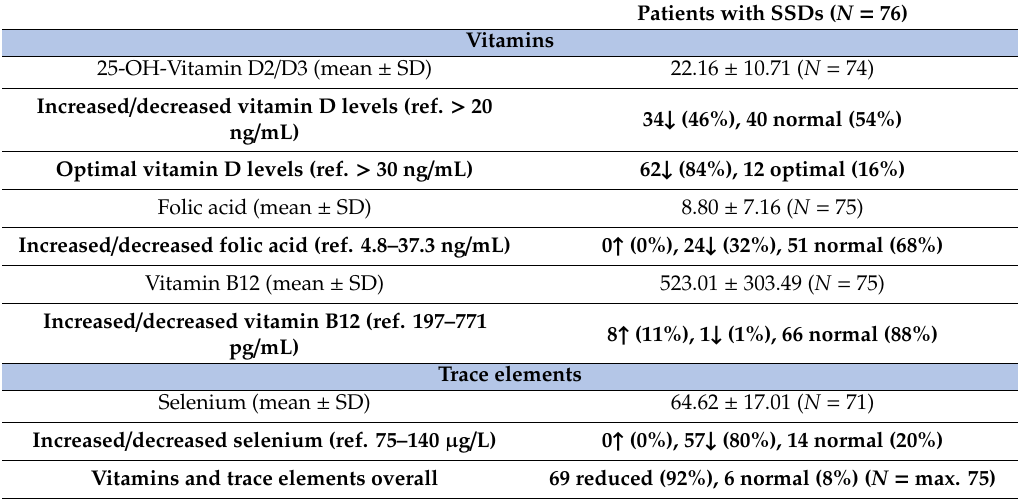
Table 4. Vitamins and trace elements in patients with schizophrenia spectrum disorders (SSDs). Values with alterations in > 10% are marked in bold, parameters with changes in > 5% are written in bold and